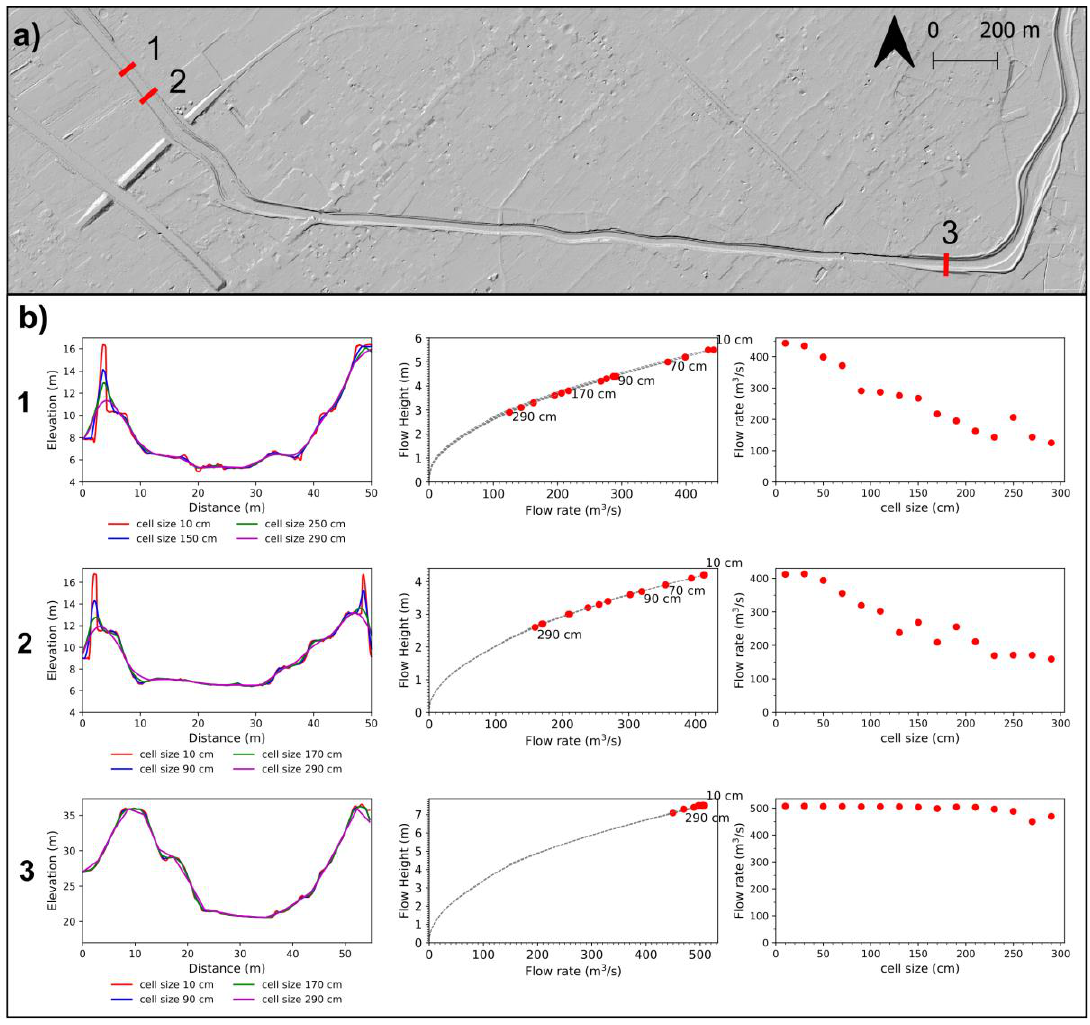
Figure 11. Effect of topography resolution on the maximum flow rate for three selected sections. ( a ) Hill-shaded map of a reach of the Versilia River with the location of the sections. ( b ) Plots of topographic profiles, maximum flow rate vs. maximum flow height, as function of the topography resolution and maximum flow rate vs. cell size.